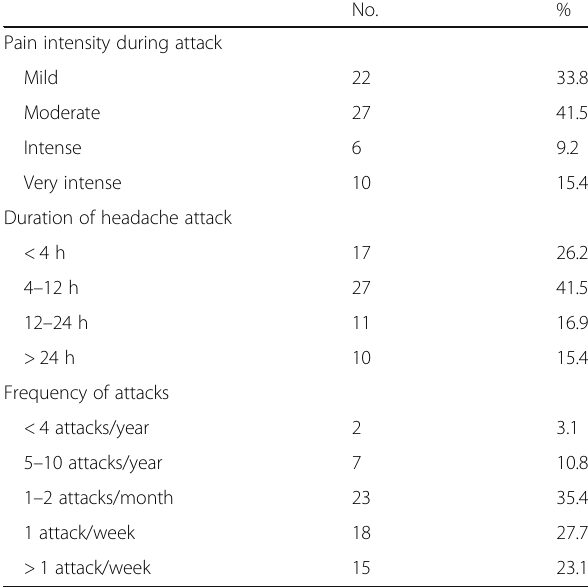
Table 1 MIGSEV scale in studied cases ( n =